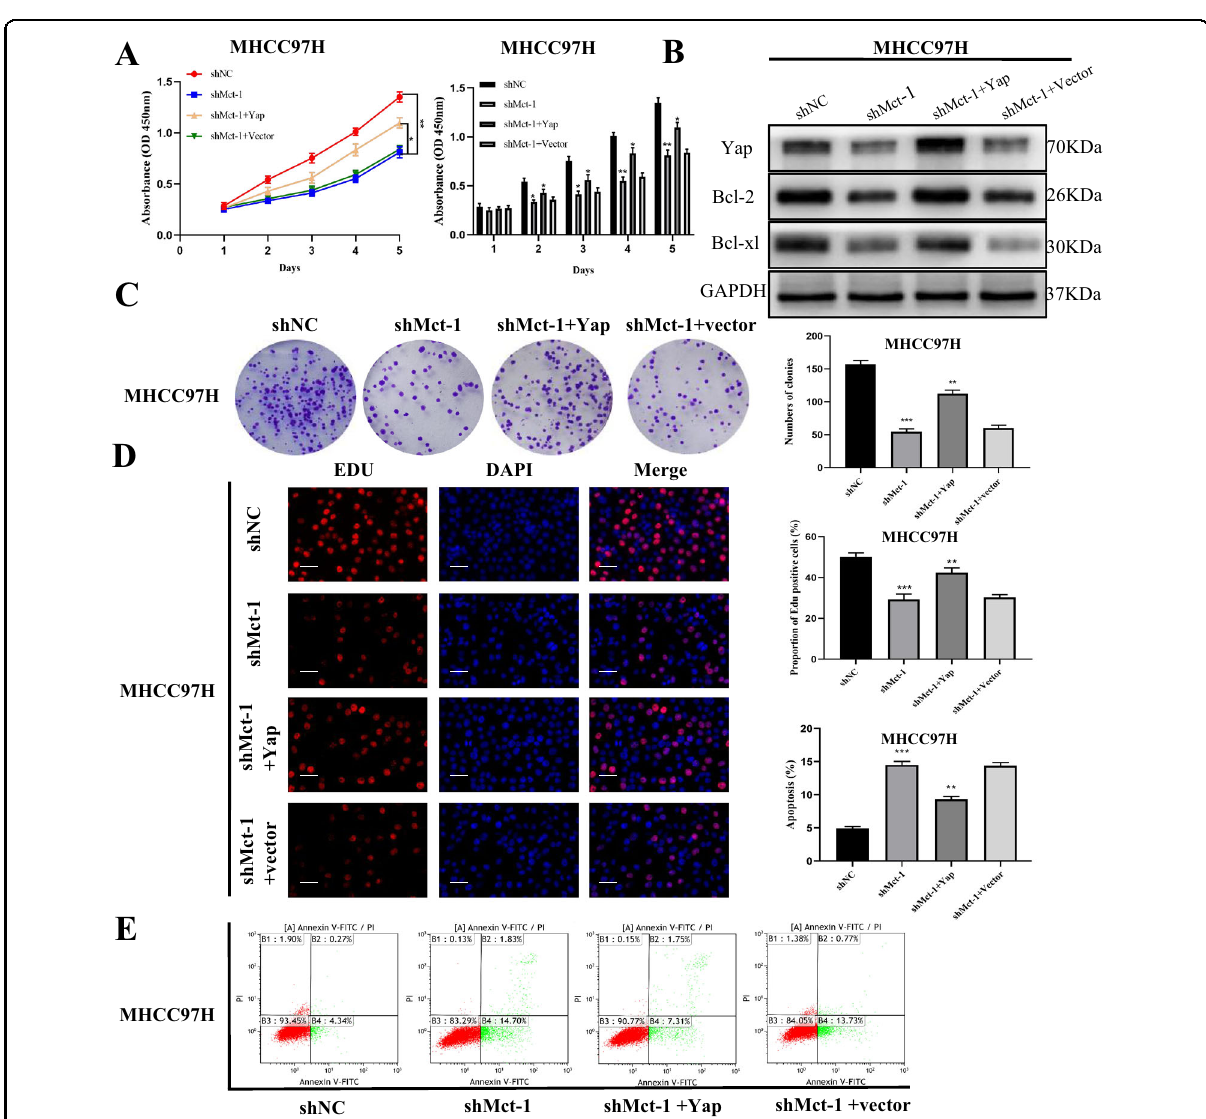
Fig. 7 Yap expression is critical for Mct-1-mediated promotion of cell proliferation and inhibition of cell apoptosis. A – D CCK-8, colony formation, Edu, and cell apoptosis analyses of Mct-1-knockdown MHCC97H cells transfected with the Yap plasmid or vector. Scale bar = 50 µm. E Protein expression of Yap together with the anti-apoptotic proteins Bcl-2 and Bcl-xl in MHCC97H cells transfected with the Mct-1 knockdown lentivirus (shMct-1) and Yap-overexpression plasmid. The data are presented as the mean ± SD of experiments performed in triplicate. * p < 0.05, ** p < 0.01, *** p <